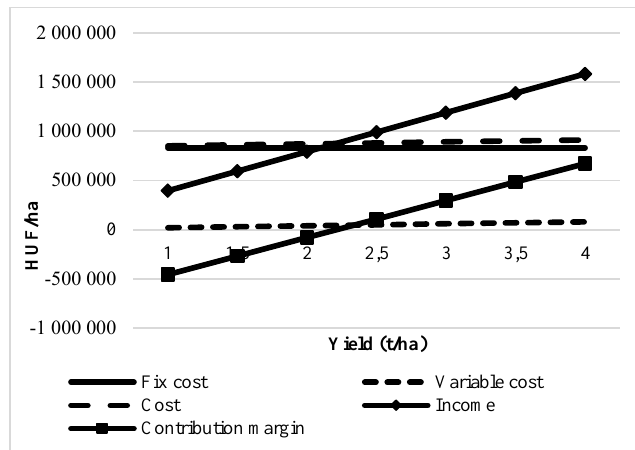
Figure 1. Break-even chart of raw walnut production on the level of direct costs and contribution margin Source: Own calculation